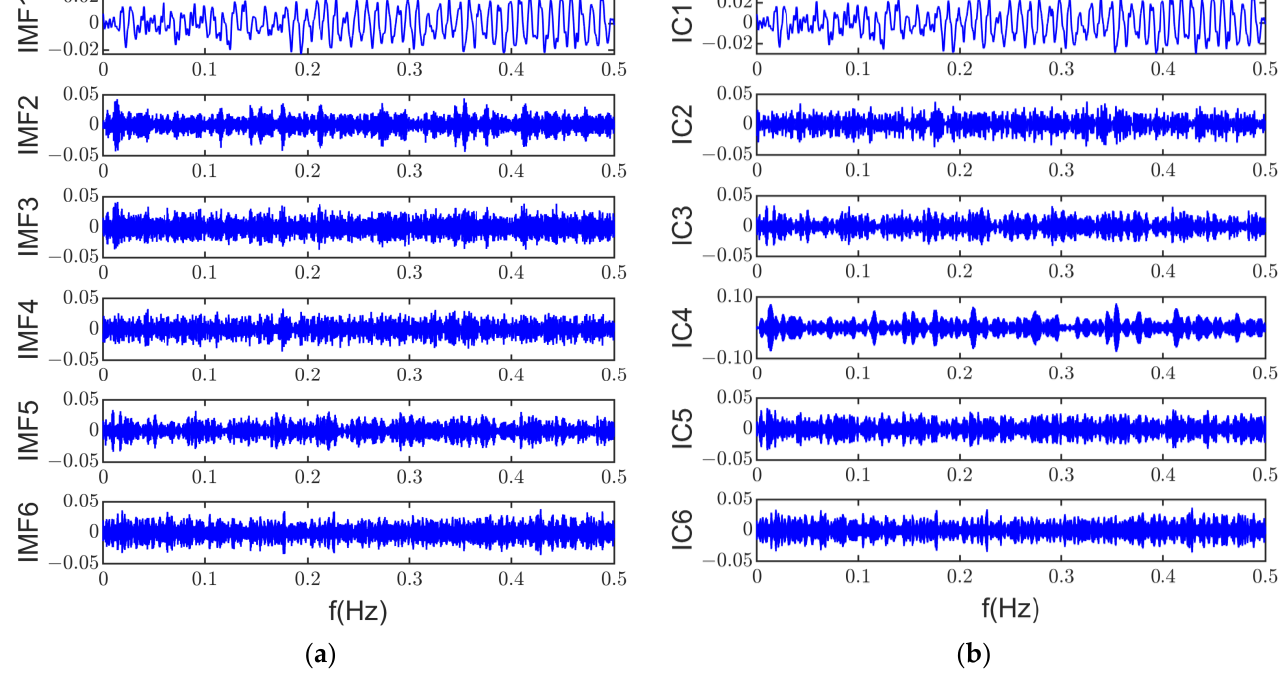
Figure 14. RobustICA input and output: ( a ) input; ( b ) output.